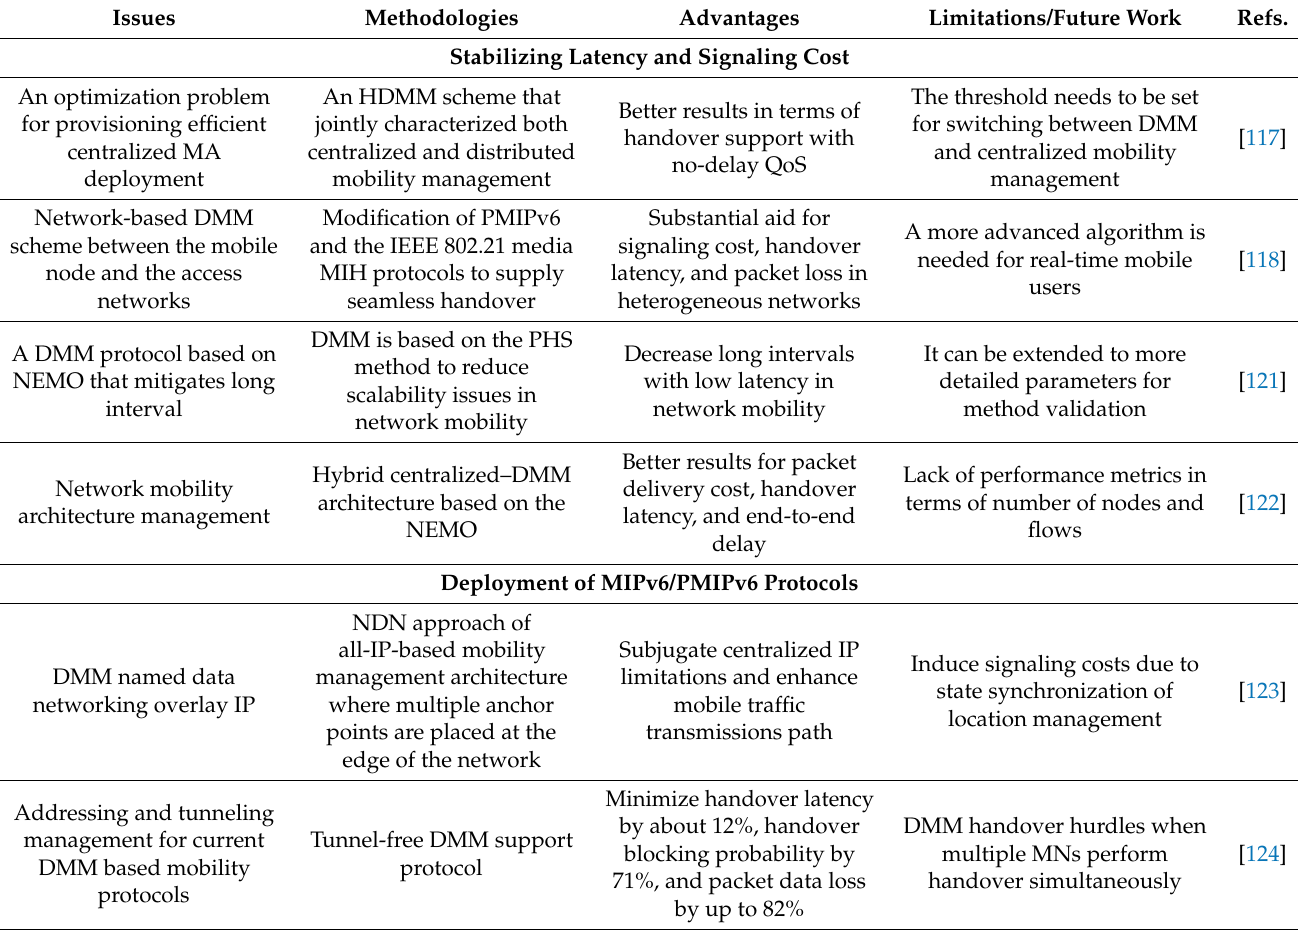
Table 3. Summary of the literature in distributed mobility